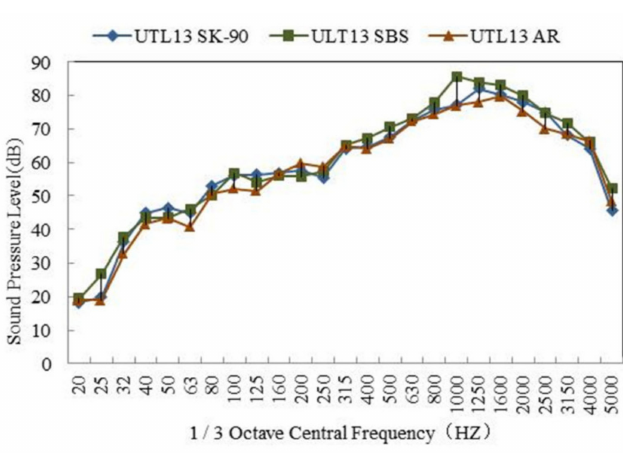
Figure 9. 1 / 3 octave band spectrum of UTL with di ff erent kinds of asphalt